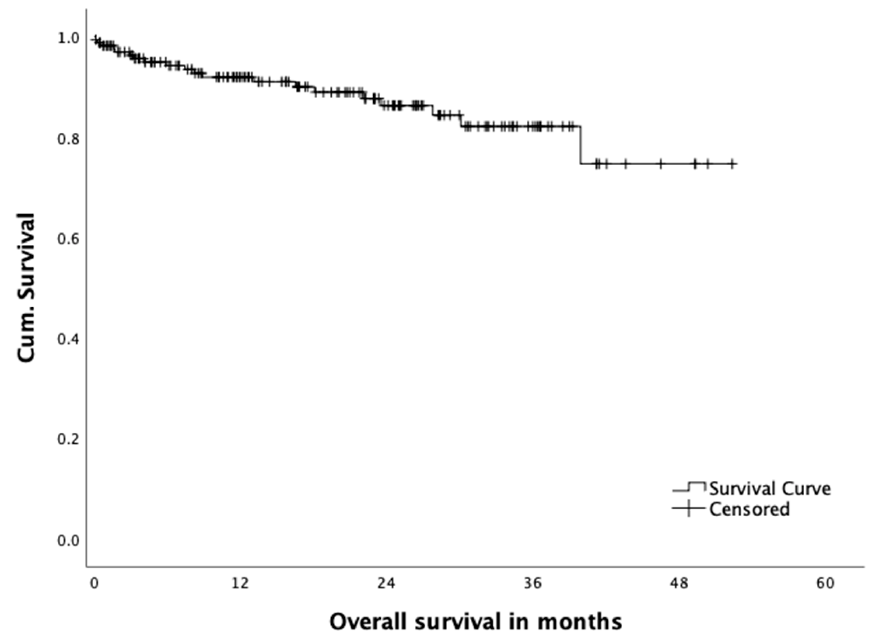
Figure 7. Overall Figure 7. Overall survival.